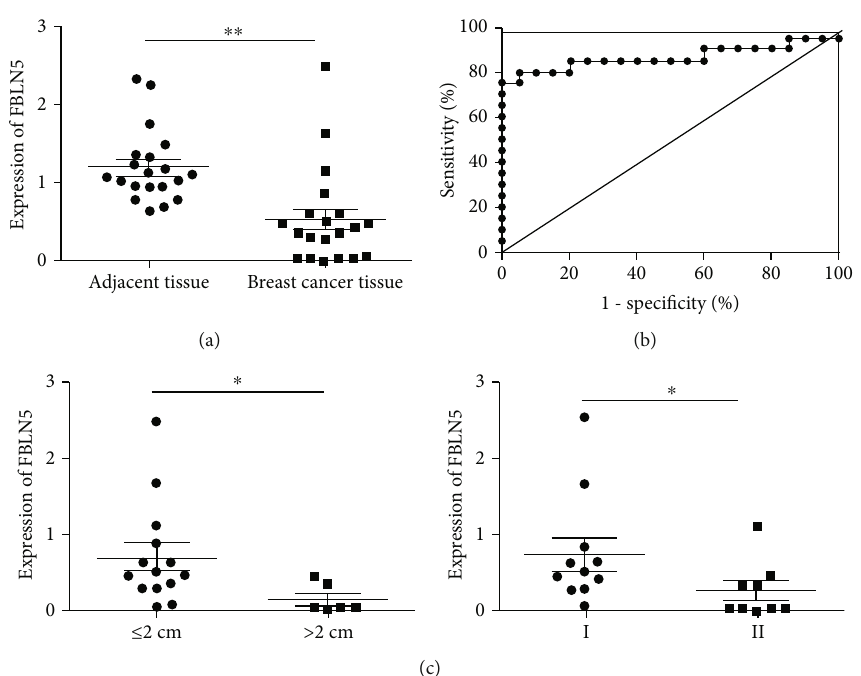
Figure 5: The detection of FBLN5 expression in breast tissues and its clinical correlation analysis. (a) The mRNA levels of FBLN5 in normal tissues adjacent to carcinoma and breast cancer tissues. ∗∗ P < 0 : 01 . (b) The diagnostic values of FBLN5 ROC curves in breast cancer tissues. (c) Correlation between the expression of FBLN5 and clinicopathological parameters (tumor diameter and TNM stage) in breast cancer tissues. ∗ P < 0 : 05